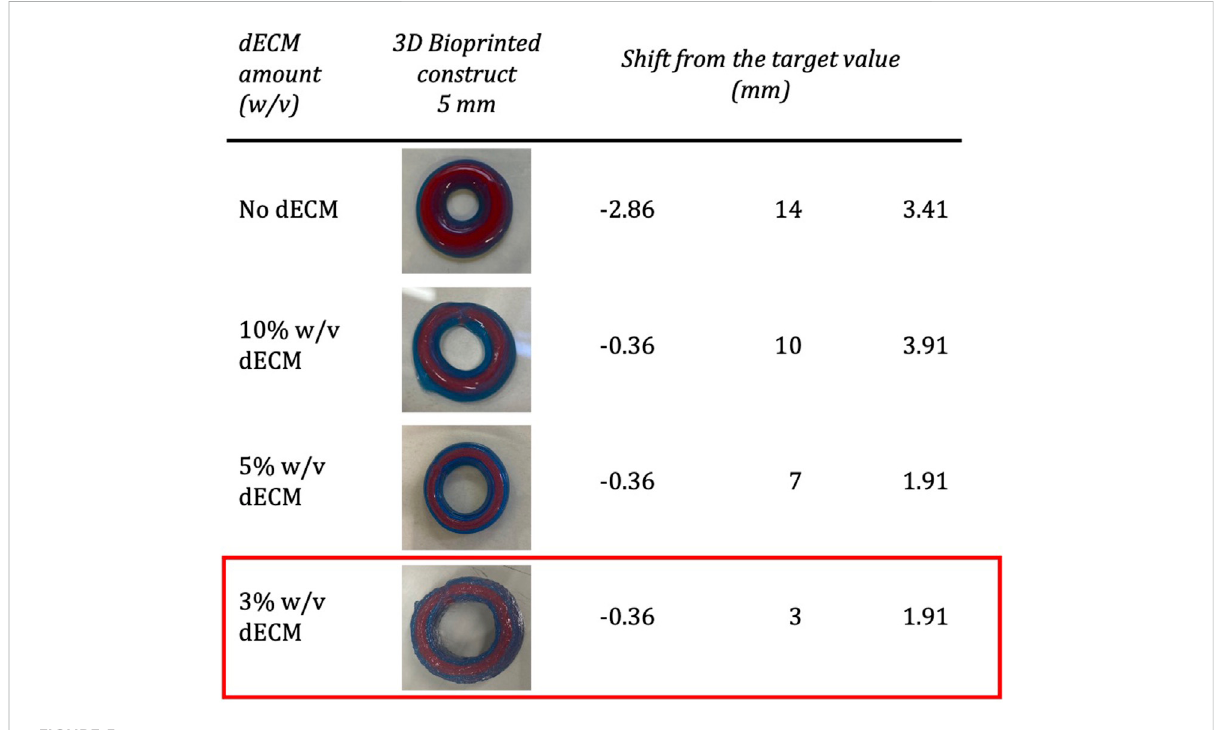
FIGURE 5 Studyofthedimensionsandshape fi delityofthebioink,reporting(column1)theamountofdECMaddedtothebasebioinkcomposedof8%w/ v gelatin, 7% w/v alginate; the images of the 3D bioprinted constructs (column 2), and the shift from the target value, obtained by comparing the thickness (T), the inner diameter (D i ) and the height of the designed construct with the printed construct. Speci fi cally, the designed dimensions are Thickness =4.64 mm,D i =20 mm, Height =4.91 mm. The ECM bioinkcomposedofgelatin 8%(w/v),alginate 7%(w/v)and dECM3%(w/v) was selected.